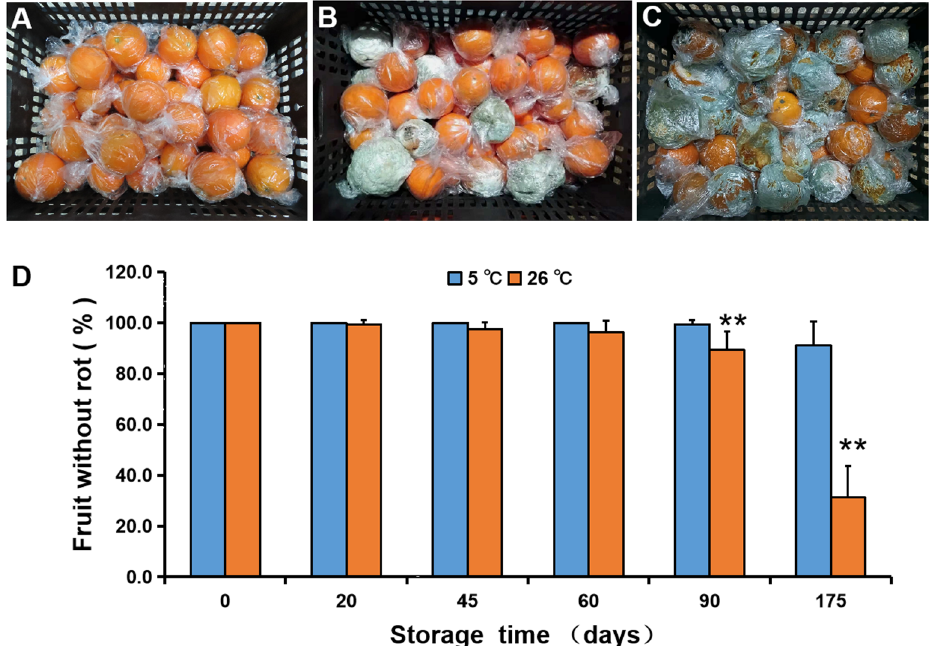
Figure 2. Fruit without rot in navel oranges during storage at 26 and 5 °C. ( A – C ) Images of bagged fruit at the beginning of storage ( A ) and after 6 months ( B ) and 1 year ( C ) at 5 °C storage condition. ( D ) Percentage (%) of bagged fruit without rot at 26 °C (blue) and 5 °C (orange) storage condition. The error bars represent the mean ± SD. **, p < 0.01 ( n = 20).